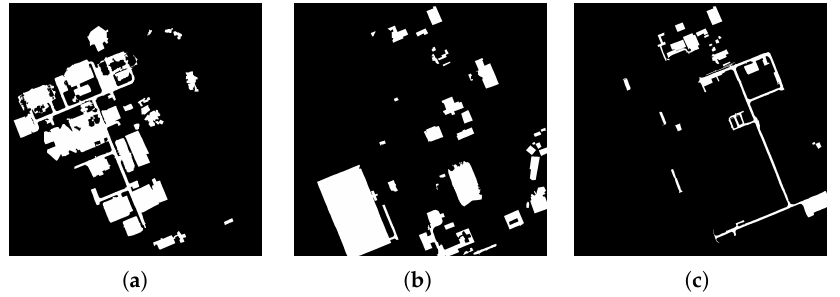
Figure 9. The ground truth of the AUAB dataset. ( a ) Ground truth of 2002 and 2006. ( b ) Ground truth of 2006 and 2009. ( c ) Ground truth of 2009 and